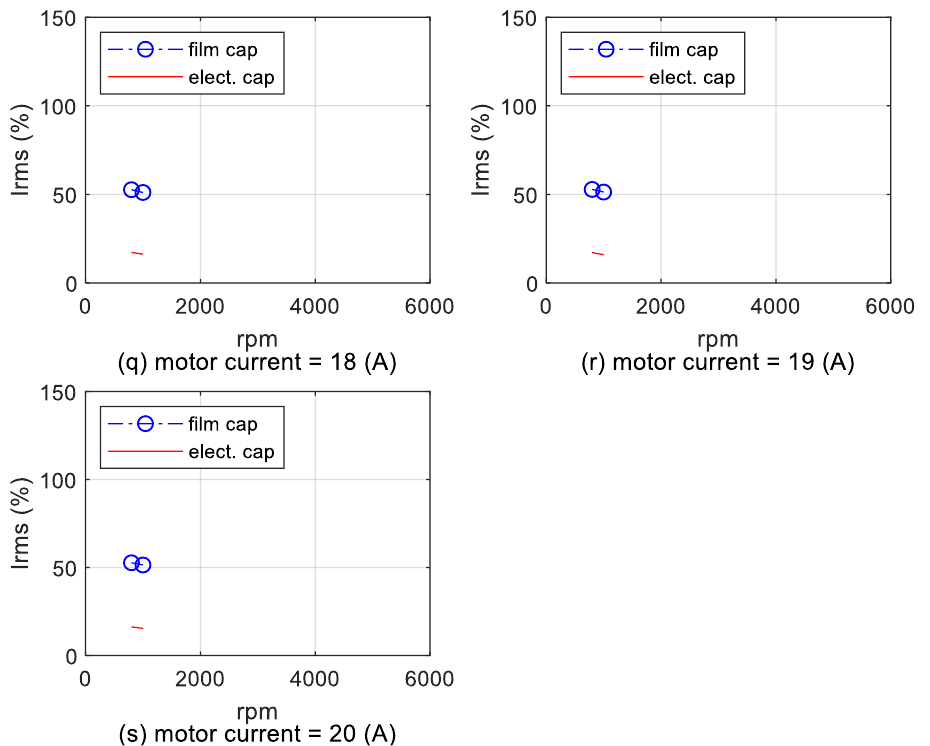
Figure 17. Percent RMS DC-link current obtained by the VSI with electrolytic and film capacitors versus motor speed. Table 2. Percent RMS DC-link current obtained by the VSI with electrolytic and film capacitor at an rpm range of 800–2000.